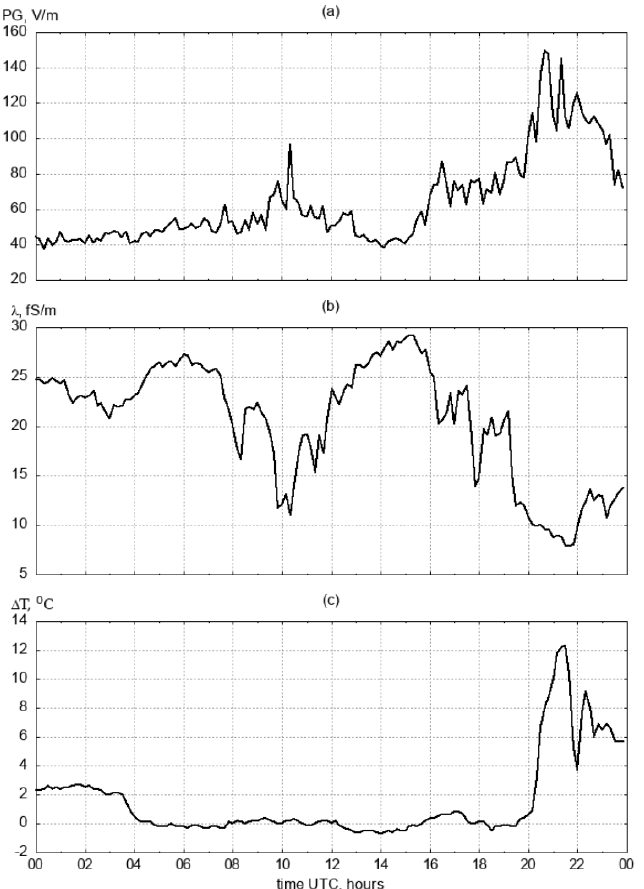
Figure 9. Sunrise effect for 6 November 2007: ( a ) PG values; ( b ) air conductivity; ( c ) air temperature difference at 3 and 25